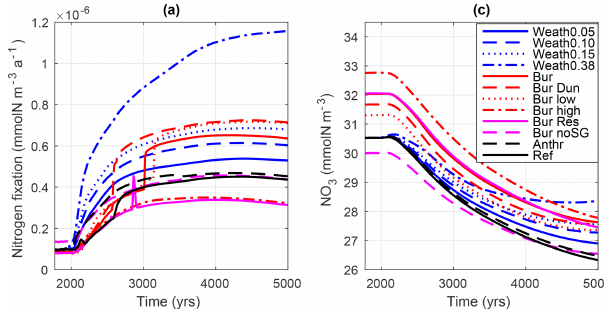
Figure 7. Globally averaged (a) N 2 fixation in mmolNm − 3 a − 1 and (b) NO − concentration in mmolNm − 3 . Simulation descrip- 3 tions can be found in Table 1.